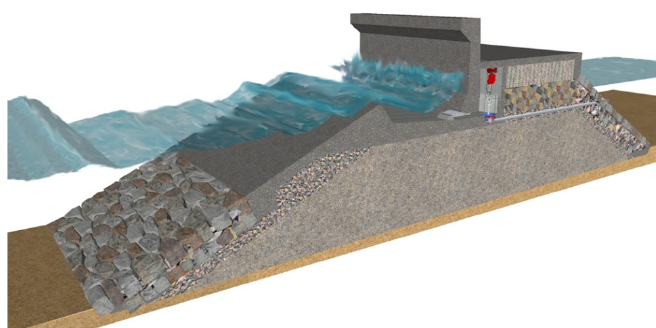
Figure 15. 3D Overtopping Breakwater for Energy Converter (OBREC) model, with the innovative seawall placed on rubble mound breakwater.